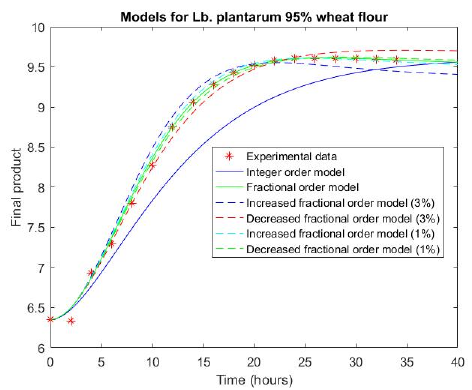
Figure 2. Comparison between simulated and experimental data for experiment 2 using L. plantarum .